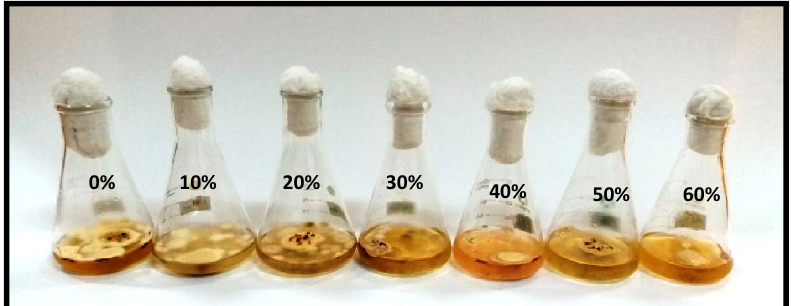
Figure 3. Effect of metabolite concentrations of P. digitatum on the growth of P.